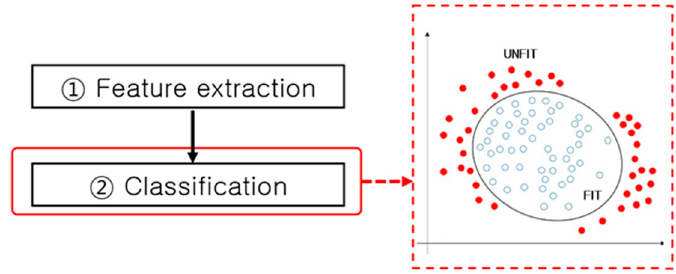
Figure 23. Classification in the fitness classification process flow.